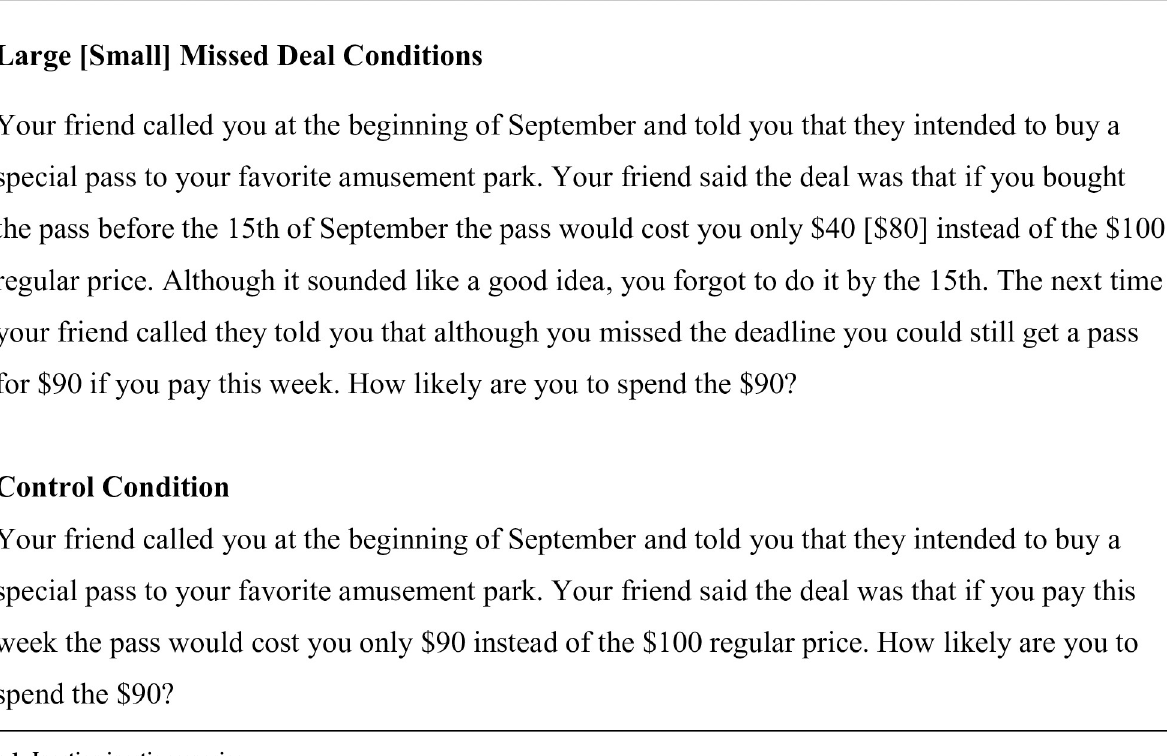
Fig 1. Inaction inertia